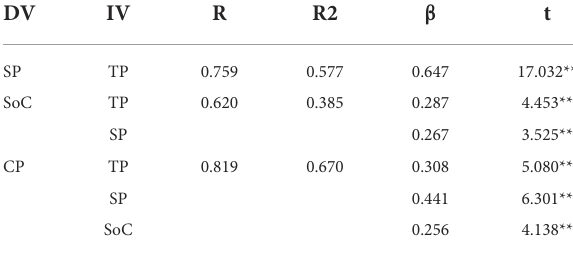
TABLE 2 Results of simple linear